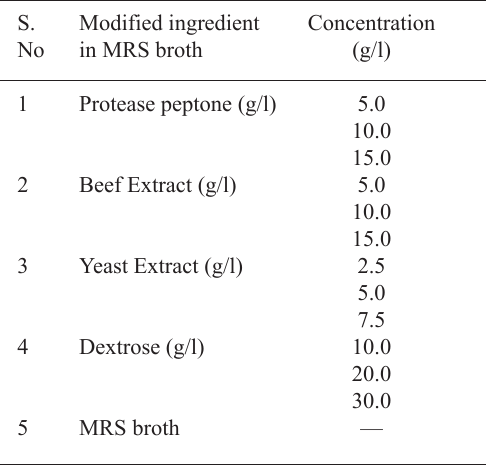
Table 1. Experimental setup for screening the influence of carbon and nitrogen sources for the production of the bacteriocin